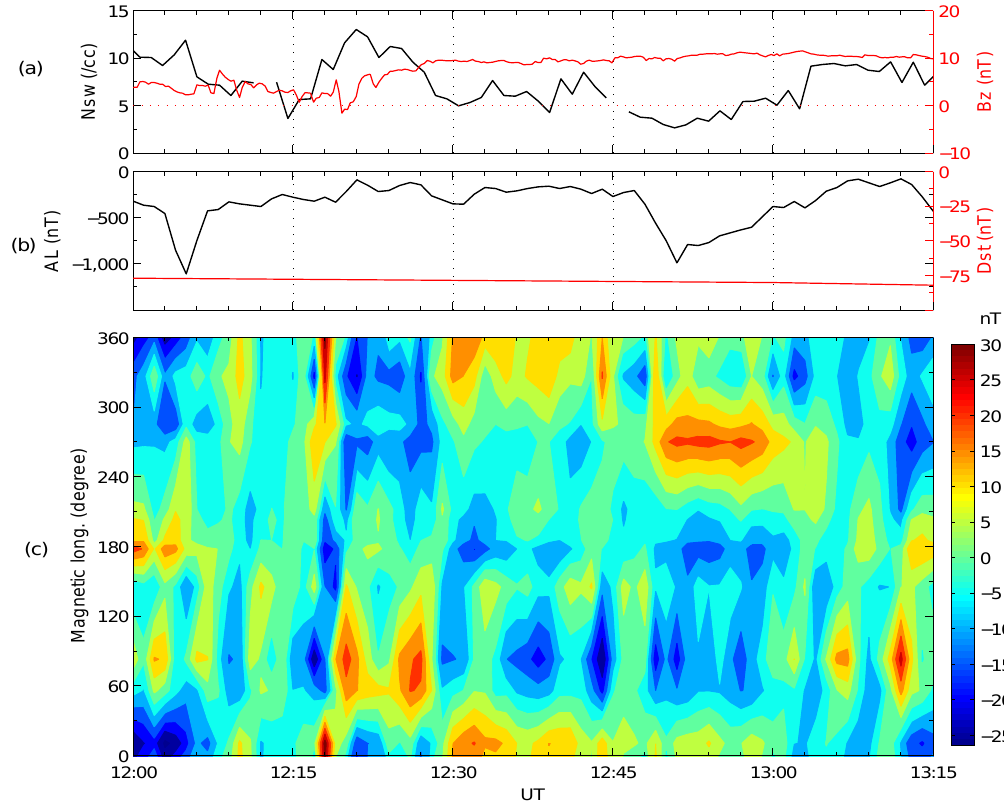
Fig. 7. Same as Fig. 3 but in time interval 12:00–13:15UT on 31 October 2005. However, contour plot of 1H asym indicates disturbance propagating eastward in longitude unlike the westward propagation shown in Fig.